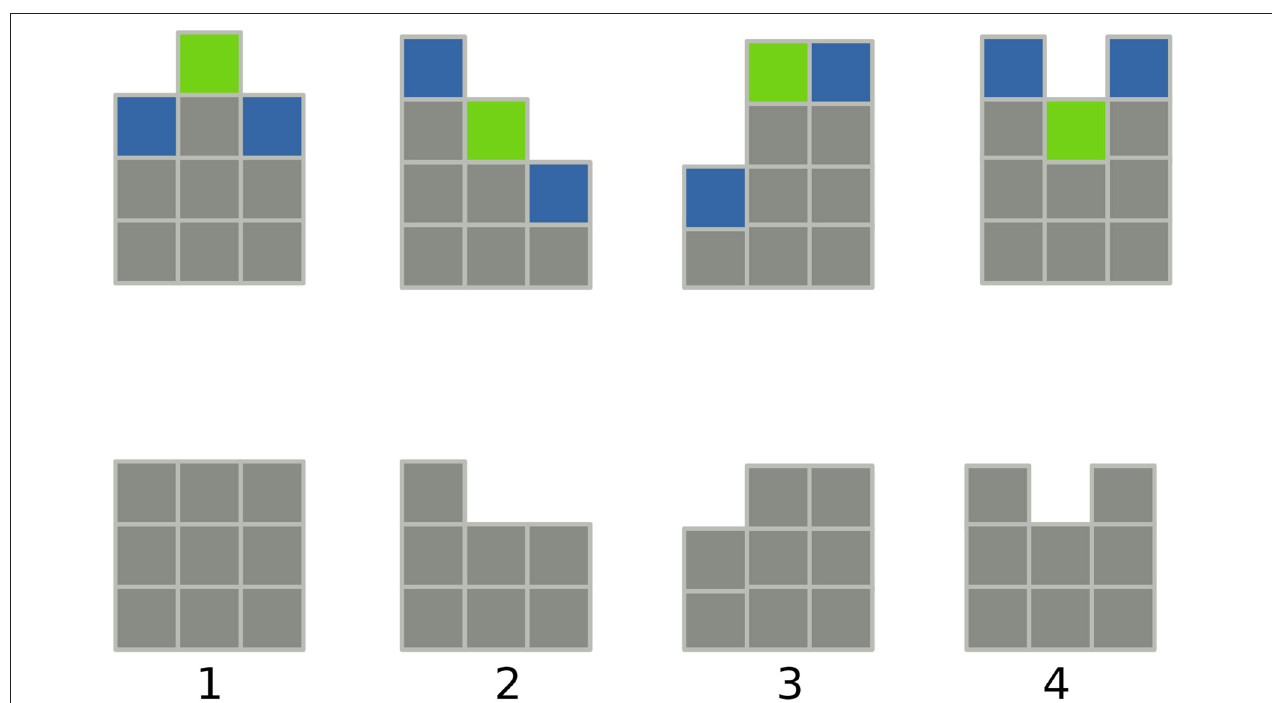
FIGURE 7 | The etching mechanism in one dimension. The figures are the four situations in which the dynamics of the etching model can be divided. The initial configuration is at the top, where the selected site, in column 2, is green, and its first neighbors, in columns 1 and 3, are shown in dark blue. After the corrosion process the final situation is exhibited at the bottom. The steps are: step 1, site selection, green; step 2, interaction with nearest neighbors; step 3, decrease of height by one. From Alves et al. [159], with permission from Physics Review